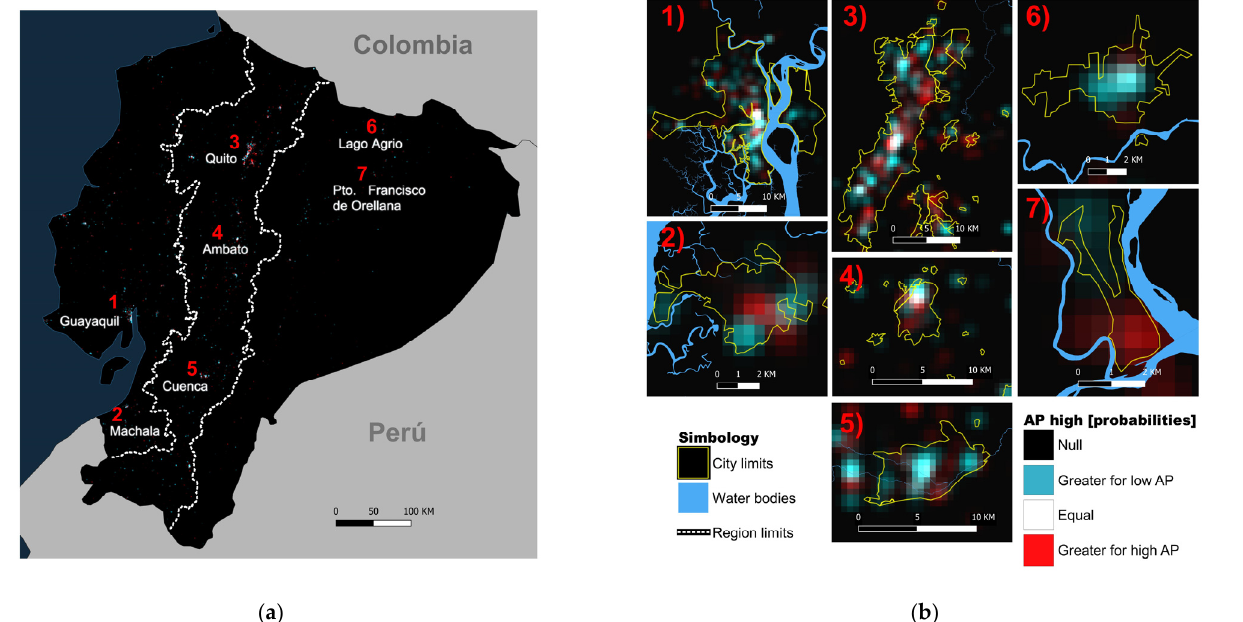
Figure 8. ( a ) Academic performance (AP) probability hot spot map for continental Ecuador. High AP probabilities are shown in red and low probabilities in blue. Equal probabilities are shown in white and their absence in black. ( b ) Maps show the largest cities. The first column shows Guayaquil and Machala in the coastal region (1,2); the second column shows Quito, Ambato, and Cuenca in the Andes (3–5); and the third column shows Lago Agrio and Puerto Franscisco de Orellana in the Amazon (6,7).